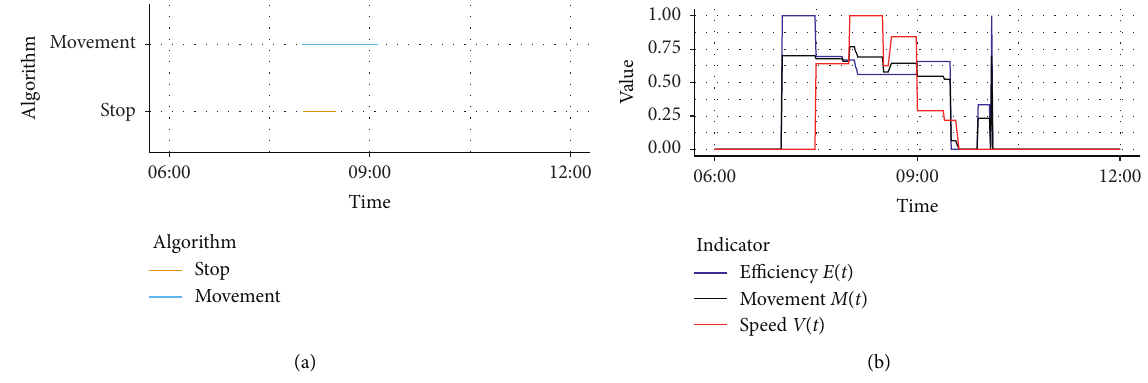
Figure 2: Example of trips extracted for one user between 6am and 12am. The top figure shows when the two cellular network-based methods have detected a trip. The bottom figure shows the movement indicators used in the MOVEMENT algorithm for the same time